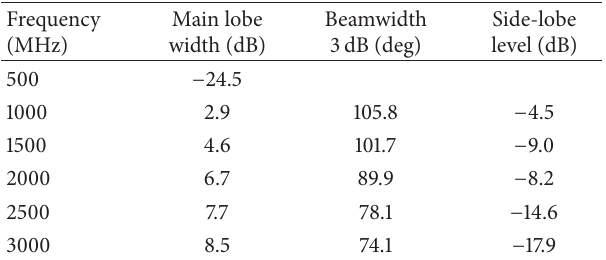
Table 2: The value of the designed antenna pattern.